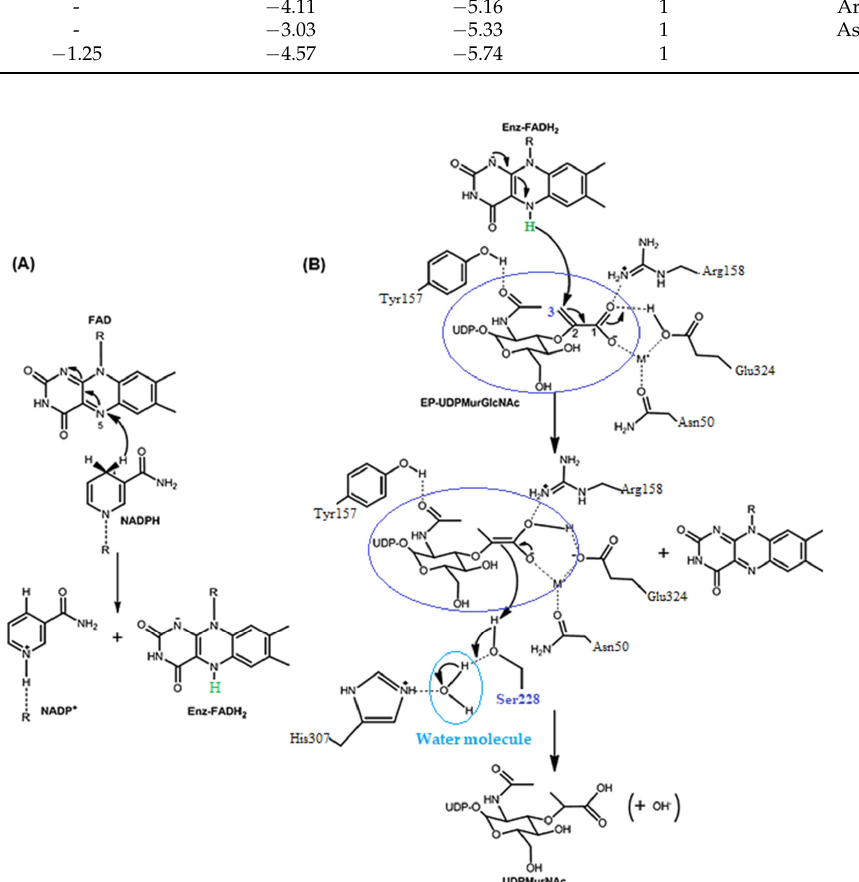
Figure 4. MurB-catalyzed reactions. The first reaction of the transfer of 4-pro-S hydride from NADPH to N-5 of Enz-FAD ( A ) [53] and the transfer of hydride from Enz-FADH2 to C-3 of its enopyrobic portion of EP-UDPGlcNAc ( B ) [54].